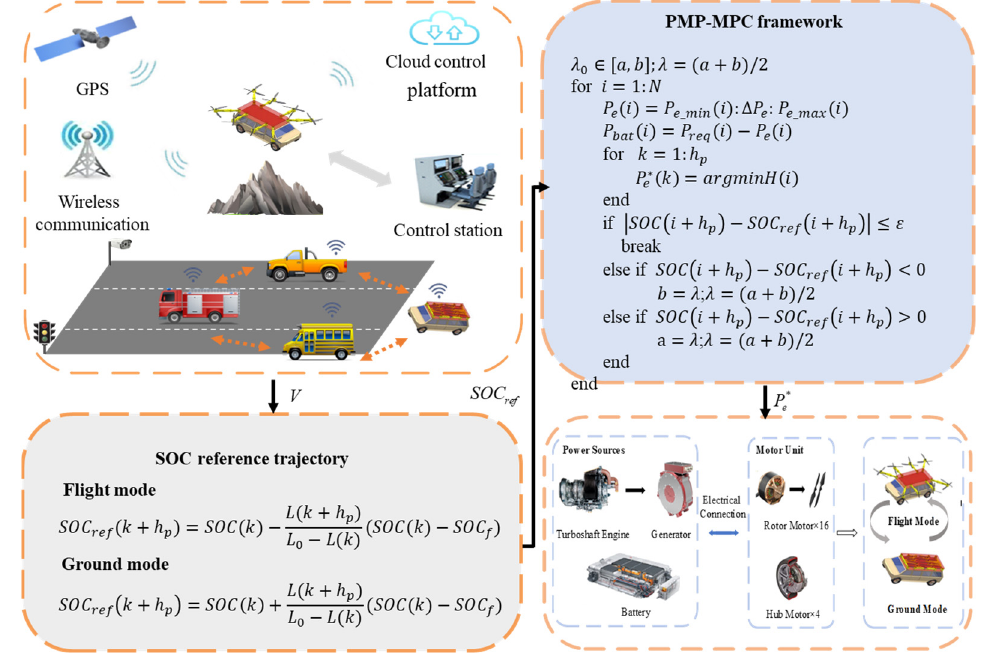
Figure 6. The overall control strategy